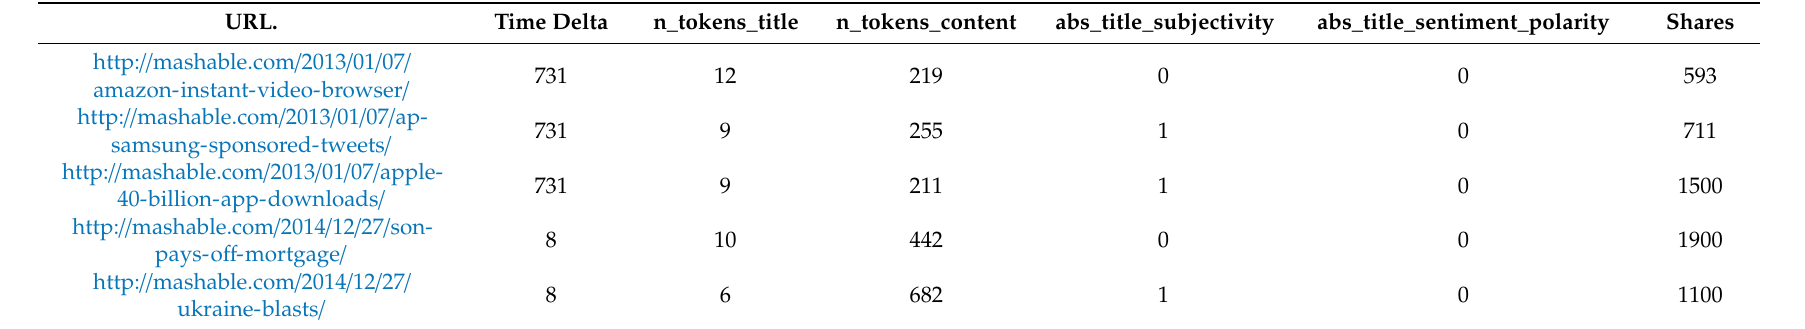
Table 3. Sample dataset (20NG) with community data group.